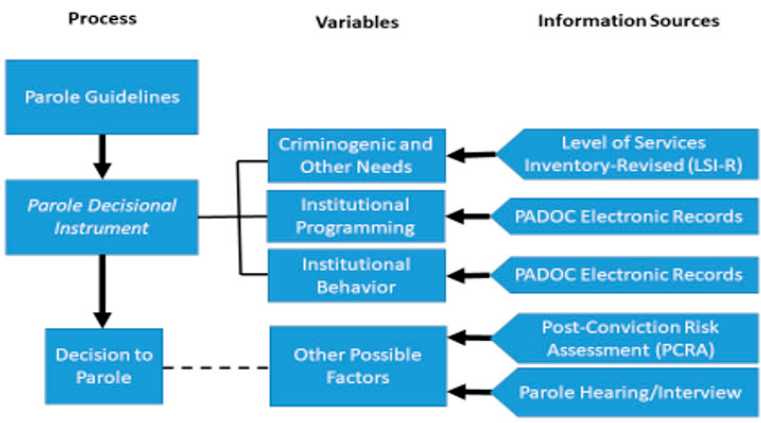
Figure 1. Heuristic of the Pennsylvania parole decision-making process.